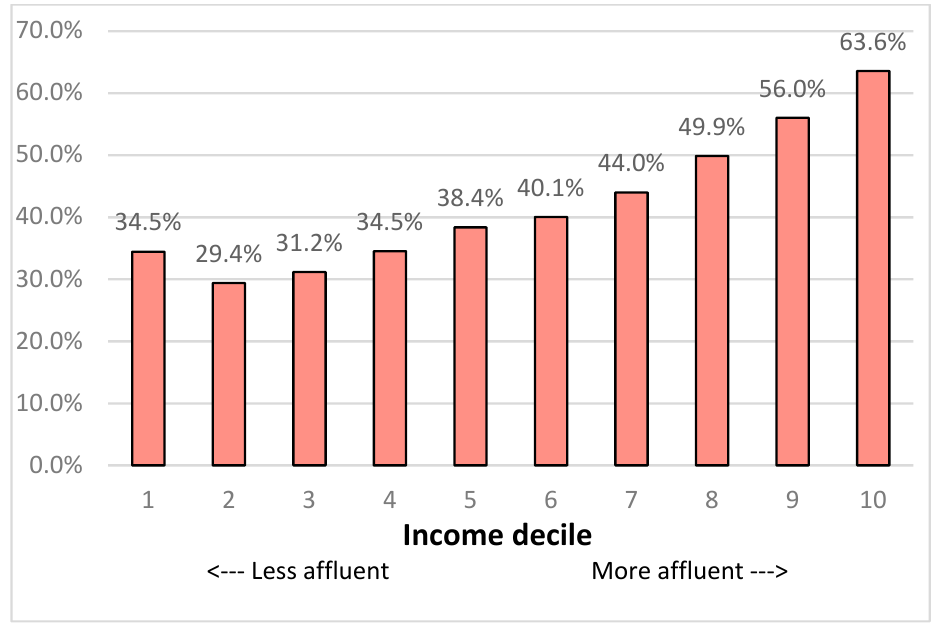
Figure 3. Over-emitters as a percentage of income deciles (the deciles are ten equal-sized groups ranked by equivalised incomes). Those in poverty are the lowest decile and 40% of the second decile. The practical interpretation of this chart is that (for example) 44.0% of households in Decile 7 would pay for more allowances, but only on the proportion of their fuel spend above the free allowance.